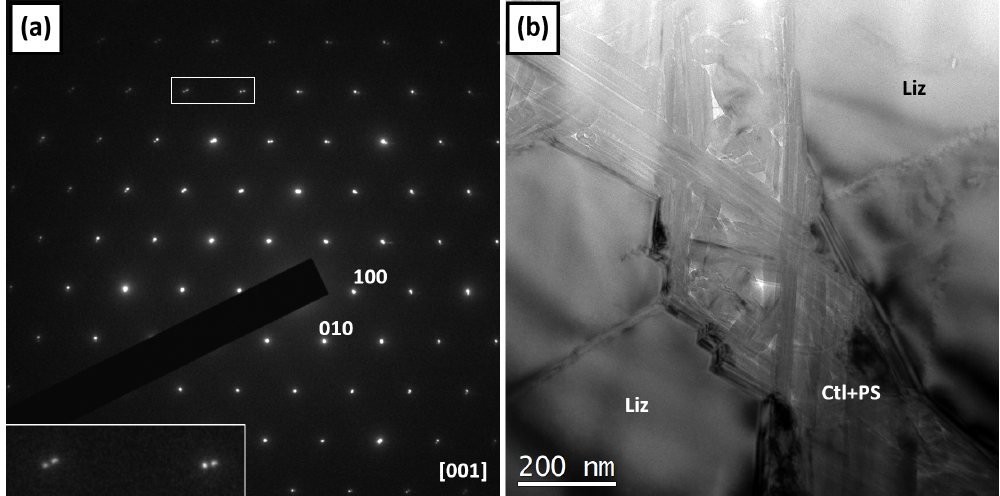
Figure 3. TEM results. (a) SAED pattern of lizardite seen along [001]. Note spot splitting in the upper left part of the image (and enlarged inset), suggesting slight misorientation among lizardite domains; (b) lizardite grains (Liz) with intermixed chrysotile (Ctl) and polygonal serpentine (PS) veins. Fibres show preferred orientation, lying parallel to the lizardite rims and mutually rotated by 120 ◦ . Zigzag stepped lizardite rims visible everywhere. Further Ctl and PS fibres lying parallel to [001] Liz are visible at the centre and in the upper central part of the image.